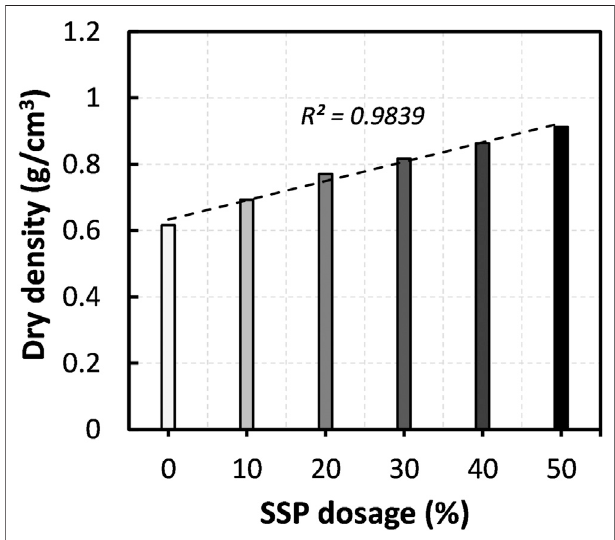
FIGURE 6 | The variation of dry density of the specimens with the increase in the SSP dosage.